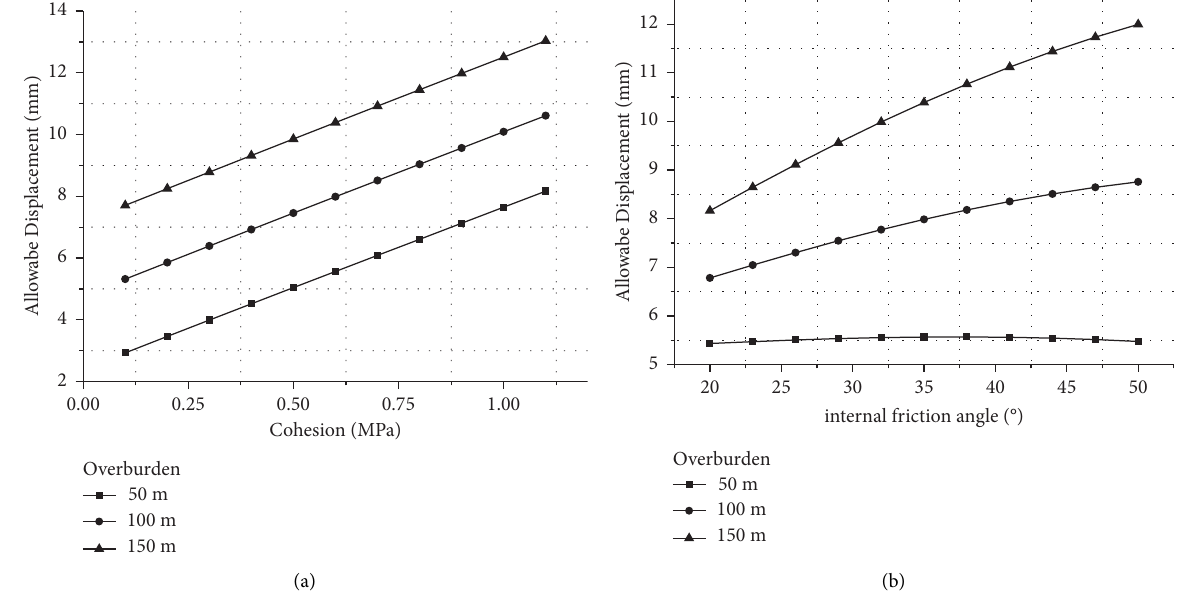
Figure 7: The curve of allowable displacement vs. both (a) cohesion and (b) internal friction angle.